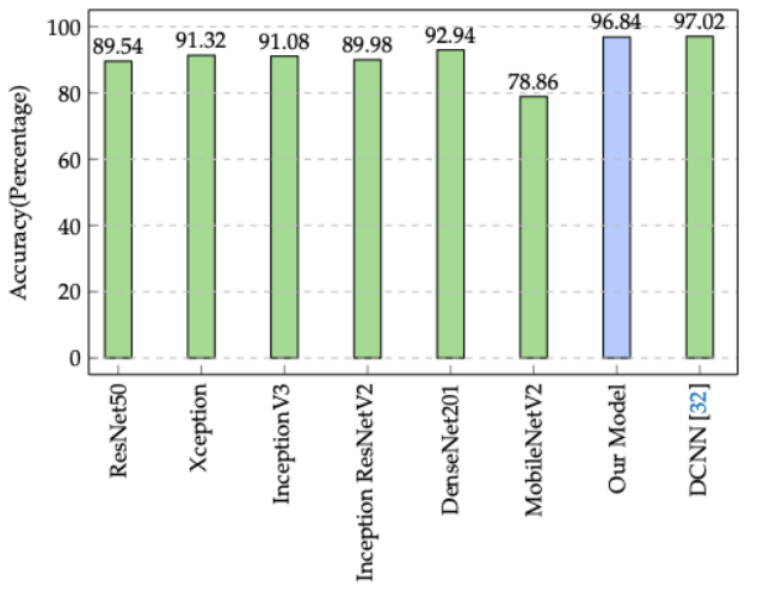
Figure 12. Comparison of our model’s accuracy to state-of-the-art